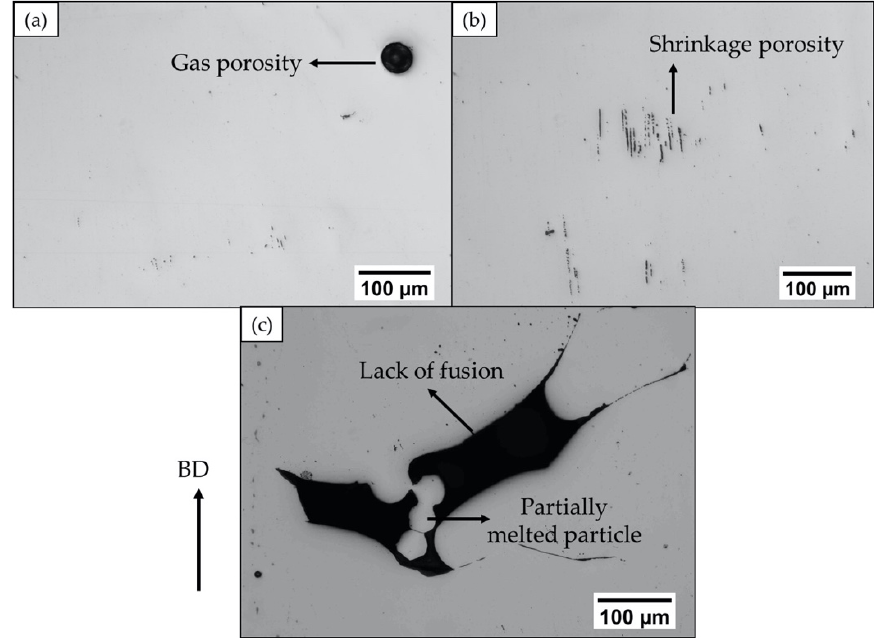
Figure 3. LOM micrographs showing the different kinds of defects present in the as-built EBM Alloy 718: ( a ) gas porosity, ( b ) shrinkage porosity, and ( c ) lack of fusion. The arrow on the left indicates the build direction.